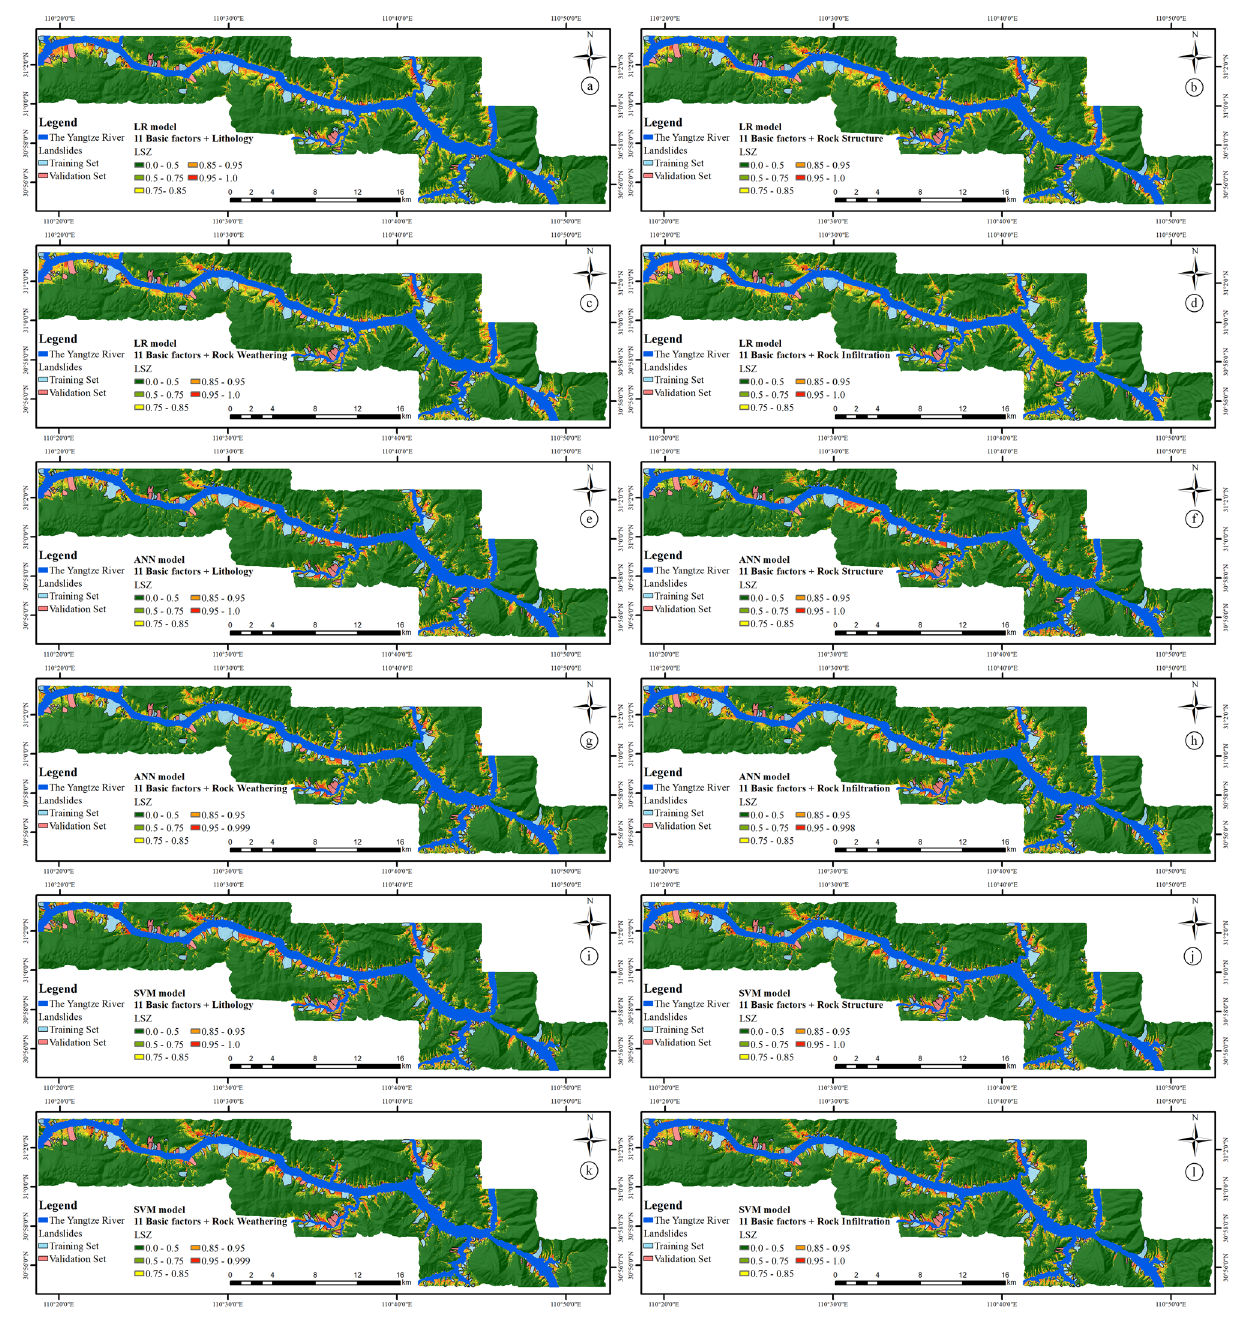
Figure 13. LSZs based on the 11 basic factors and ( a ) lithology factor by LR model, ( b ) rock structure factor by LR model, ( c ) rock weathering factor by LR model, ( d ) rock infiltration factor by LR model, ( e ) lithology factor by LR model, ( f ) rock structure factor by ANN model, ( g ) rock weathering factor by ANN model, ( h ) rock infiltration factor by ANN model, ( i ) lithology factor by LR model, ( j ) rock structure factor by SVM model, ( k ) rock weathering factor by SVM model, and ( l ) rock infiltration factor by SVM